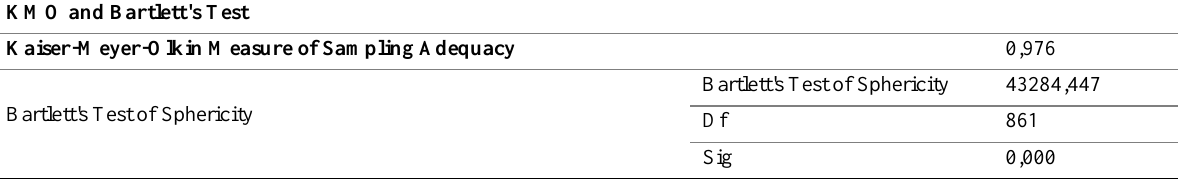
Table 2: Toxic Leadership and Organizational Trust (Independent Variable) KMO and Bartlett's Test KMO and Bartlett's Test